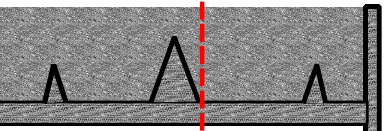
Figure 20. Location of the cross-section of RTSF and MSF slabs (red dashed line).